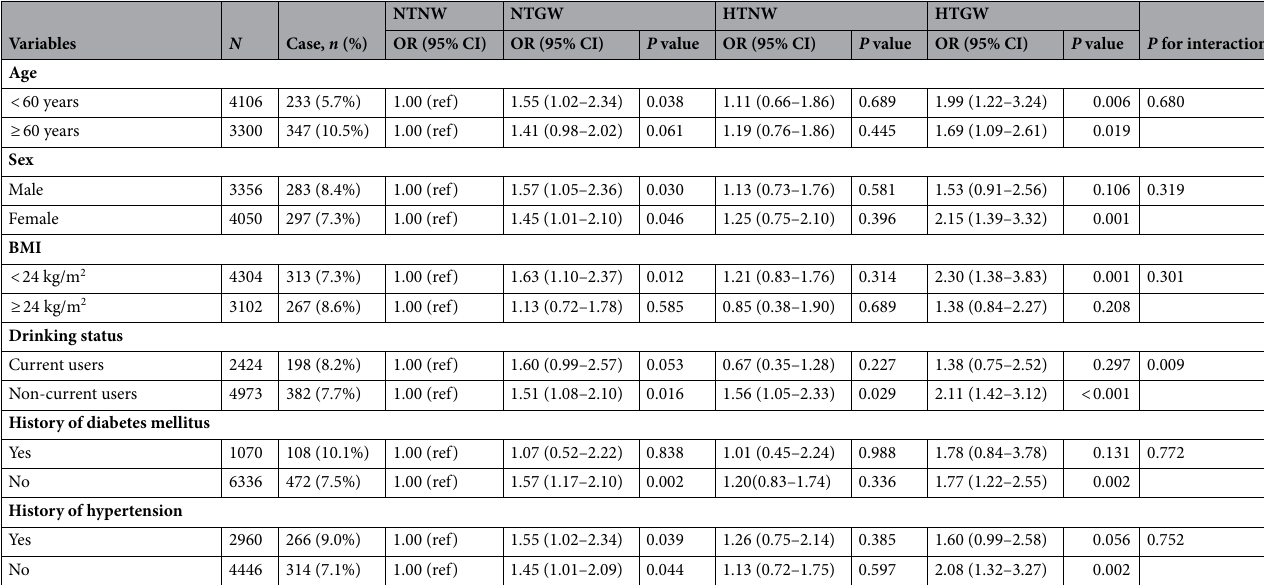
Table 3. Stratified analysis of the associations between triglyceridemic-waist phenotypes and incident chronic kidney disease. NTNW normal triglyceride levels and normal waist circumference, NTGW normal triglyceride levels with enlarged waist circumference, HTNW high triglyceride levels and normal waist circumference, HTGW high triglyceride levels and enlarged waist circumference, OR odds ratio, CI confidence interval. Except for the stratified variables in each stratum, analysis adjusted for baseline age, sex, residence, education level, smoking and drinking status, BMI, HDL-c, history of DM, hypertension and CVD, use of hypoglycemic agents, anti-hypertensive agents, and lipid-regulating agents, as well as baseline eGFR